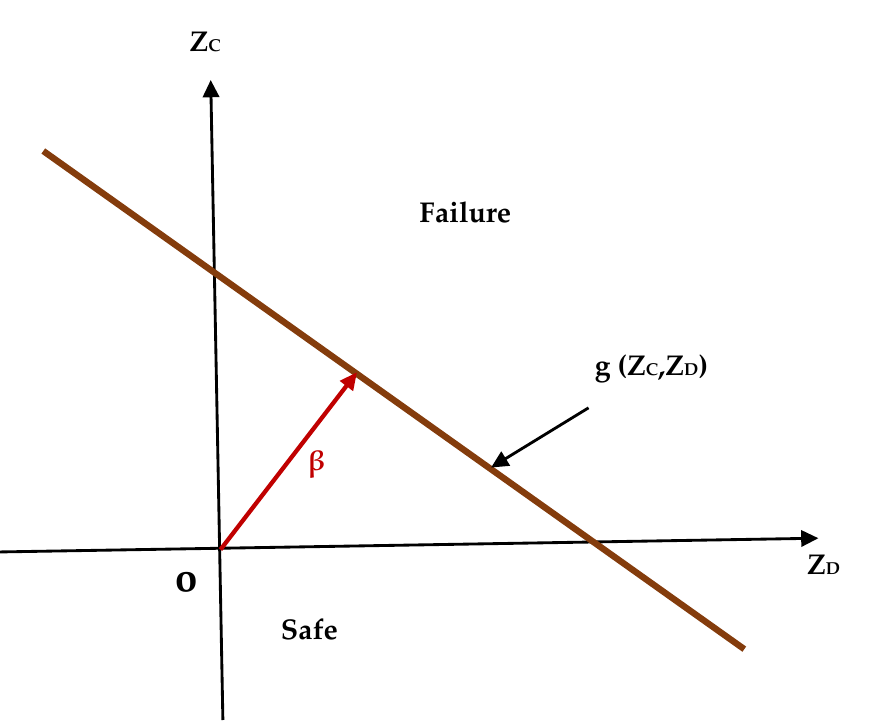
Figure 4. Geometrical representation of reliability index.